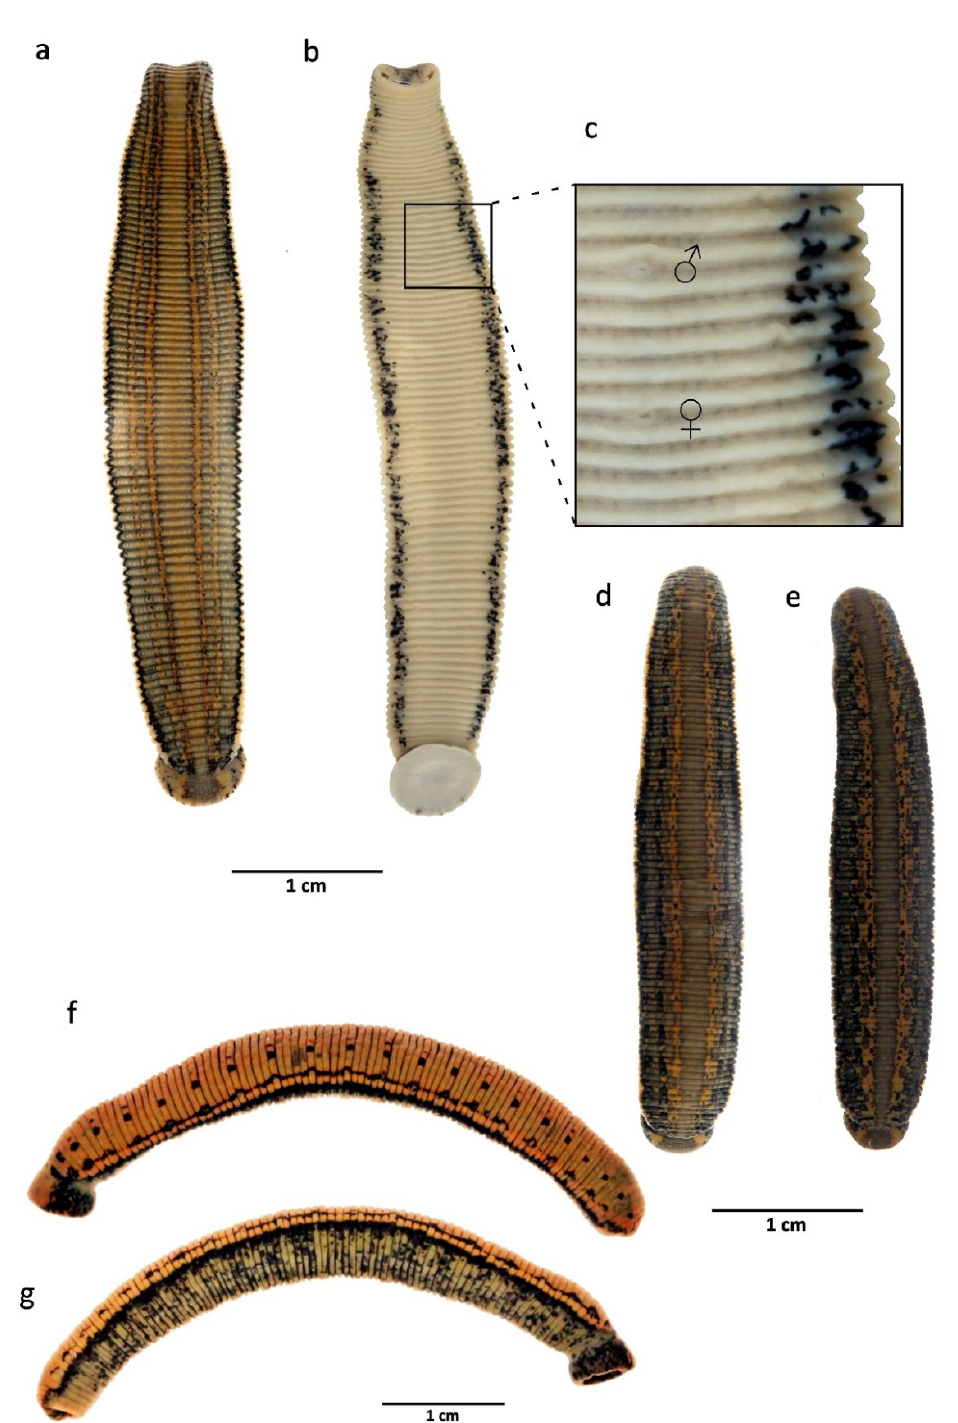
Figure 5. Iberian species of medicinal leeches treated in this work. ( a , b ) dorsal and ventral views of the holotype of Hirudo verbana bilineata ssp. nov; ( c ) detailed view of genital pores of the same; ( d , e ) Hirudo verbana “typical” from Galicia (NW Spain), dorsal view; ( f , g ) dorso-lateral and ventro-lateral views of Hirudo troctina from Asturias (N Spain). Diagnosis: Medium-sized species, maximal length of about 80 mm including suckers; pigmentation of dorsum brownish to greenish with two pairs of distinct orange/reddish longitudinal lines or stripes, with or without small quadrangular or rounded dark spots